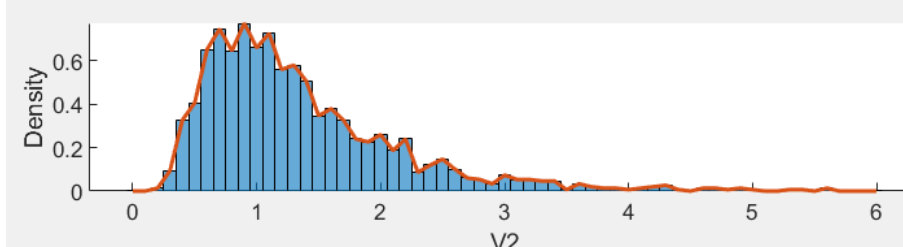
Figure 8. Histogram of the probability density function of V2(t).